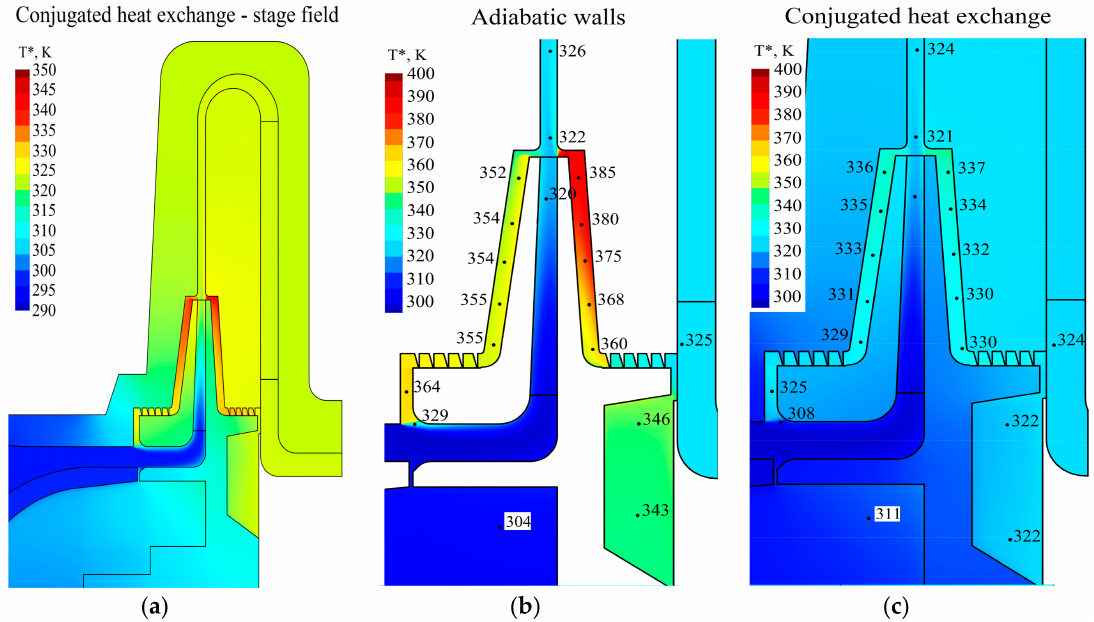
Figure 3. Full temperature field. ( a ) In optimal mode for the model with a conjugate heat exchange of the flow part; ( b , c ) For the model with adiabatic walls and a conjugate heat exchange,